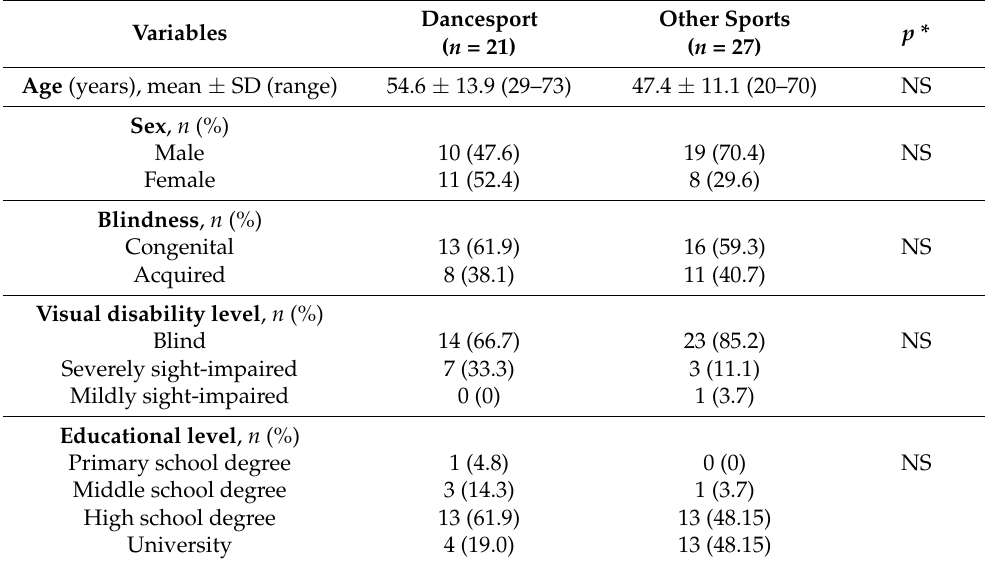
Table 1. Demographic data and description of visual disability of visually impaired subjects practicing dancesport and other sports.